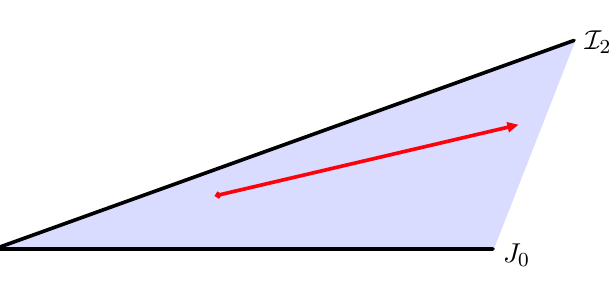
Figure 7 . In limits of J -class B all the remaining K(cid:127)ahler cone generators except for J 0 belong to the set as de(cid:12)ned in I 2